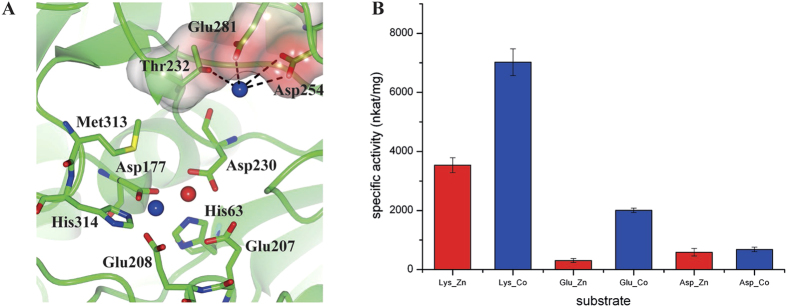
The M3 site broaden the PfTET3 substrate preferences.(A) P1 pocket of PfTET3 in electrostatic surface representation. Blue spheres are Co2+ ions, red sphere is a Zn2+ ion. For the sake of the clarity, only the residues interacting with the M3 site are highlighted. The presence of M3 modify the electrostatic properties of P1 allowing the degradation of glutamate. (B) Substrate specificity of PfTET3 is expanded towards glutamate in the presence of Co2+ (blue rectangles) at 85 °C. In the absence of Co2+ (red rectangles) PfTET3 is almost inactive. Error bars are standard deviations of three independent measurements.